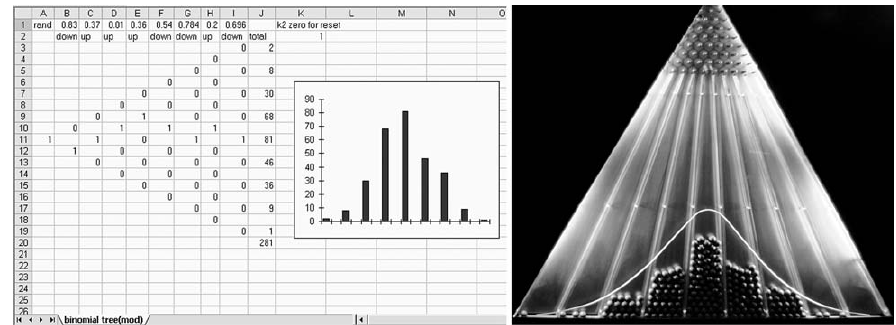
Figure 2. Spreadsheet (left) and physical model (right) of binomial function. Source: Physical model courtesy of Antoine Taveneaux (used under Creative